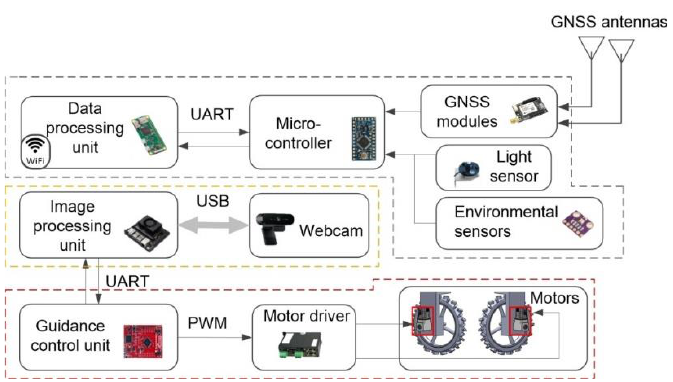
Figure 2. The guidance and control system architecture for a two-wheeled robot trailer.